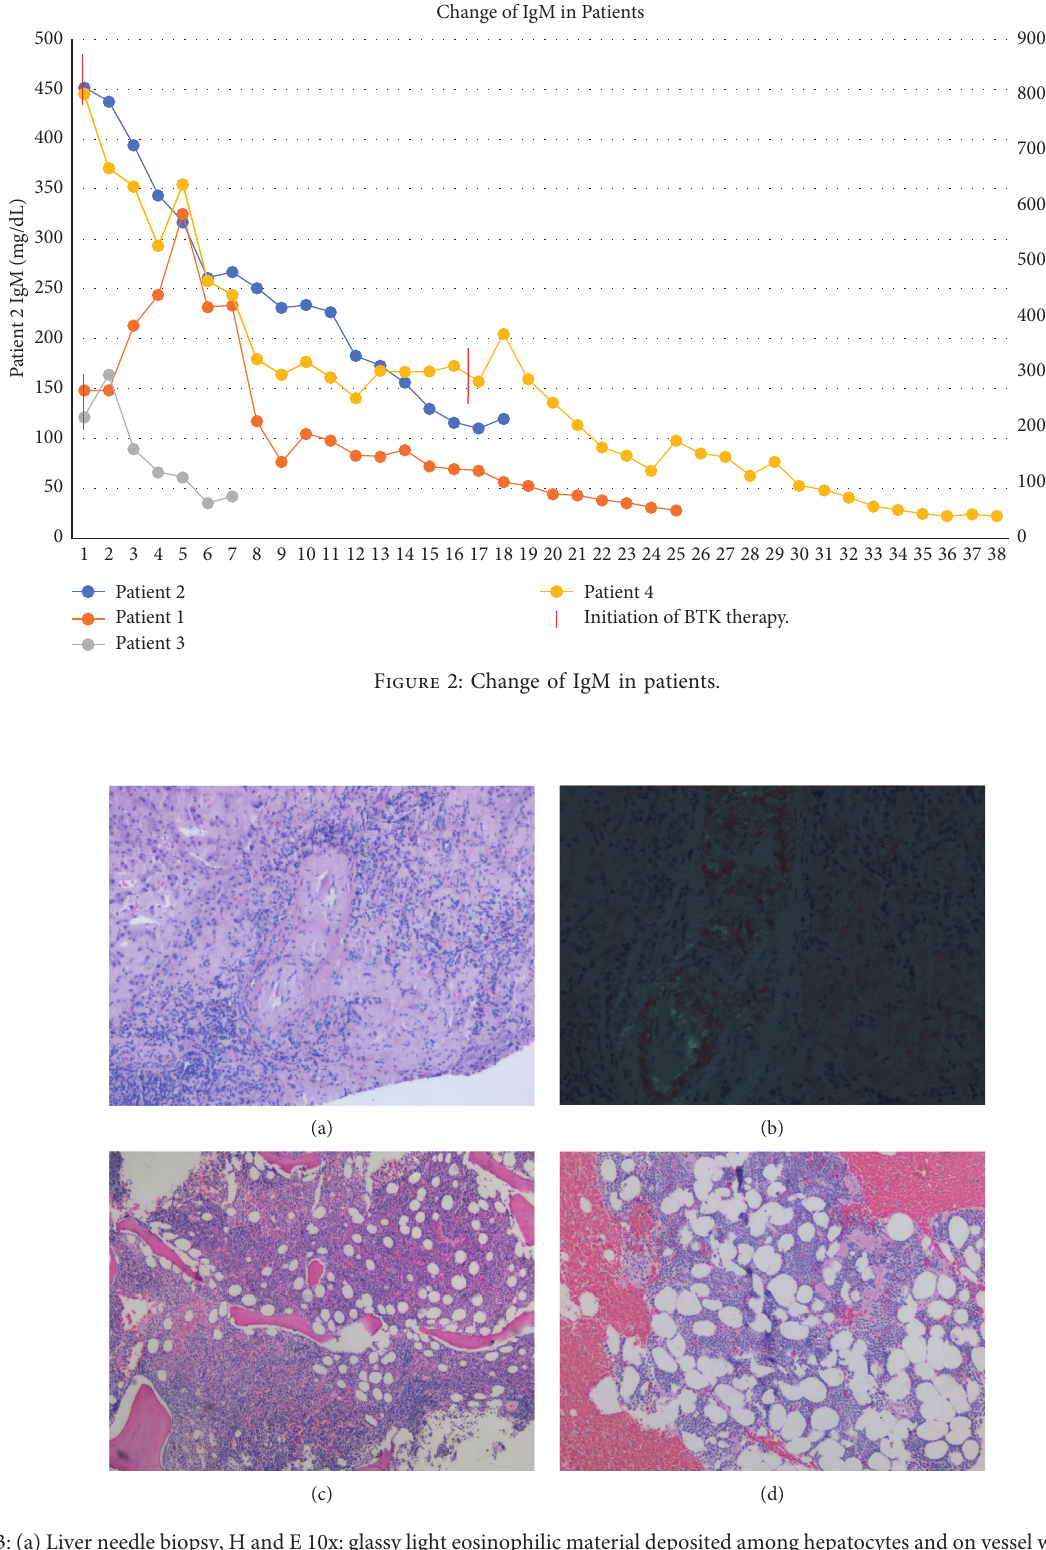
Figure 3: (a) Liver needle biopsy, H and E 10x: glassy light eosinophilic material deposited among hepatocytes and on vessel walls. (b) Liver needle biopsy, Congo red stain 20X: polarization of Congo red shows apple-green birefringence, most prominently around the vessel wall. (c) BM H and E 5x: diffuse involvement by small atypical lymphoid cells and rare plasma cells (60% of cellularity). (d) BM clot H and E 10x: bone marrow spicule diffusely involved by small atypical lymphoid